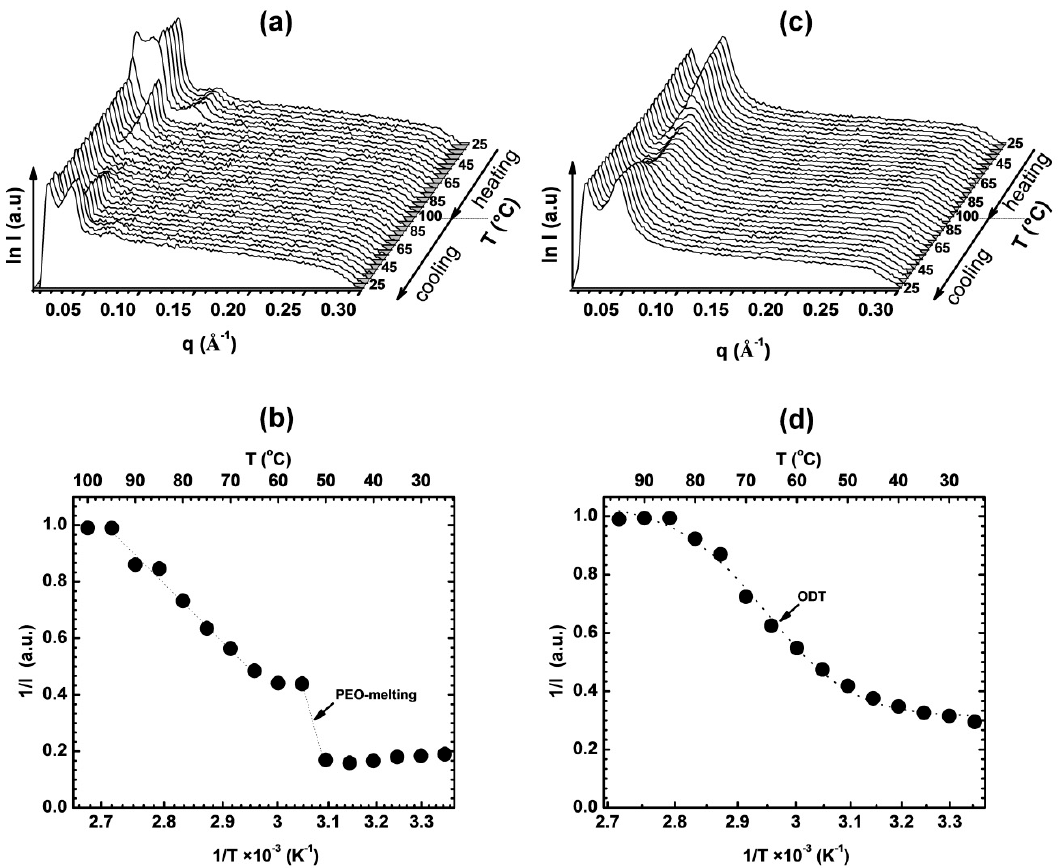
Figure 4. Temperature dependent SAXS data and the corresponding inverse intensities as a function of inverse temperature for the neat diblock PEO-b-MA / CB ( a , b ) and for a sample with EO:Li + = 16 ( c , d ). For the neat diblock, ODT is followed by PEO crystallization. For EO:Li + = 16, the system is amorphous and no changes in scattering intensity are observed on cooling below ODT. Dotted lines are visual guides.